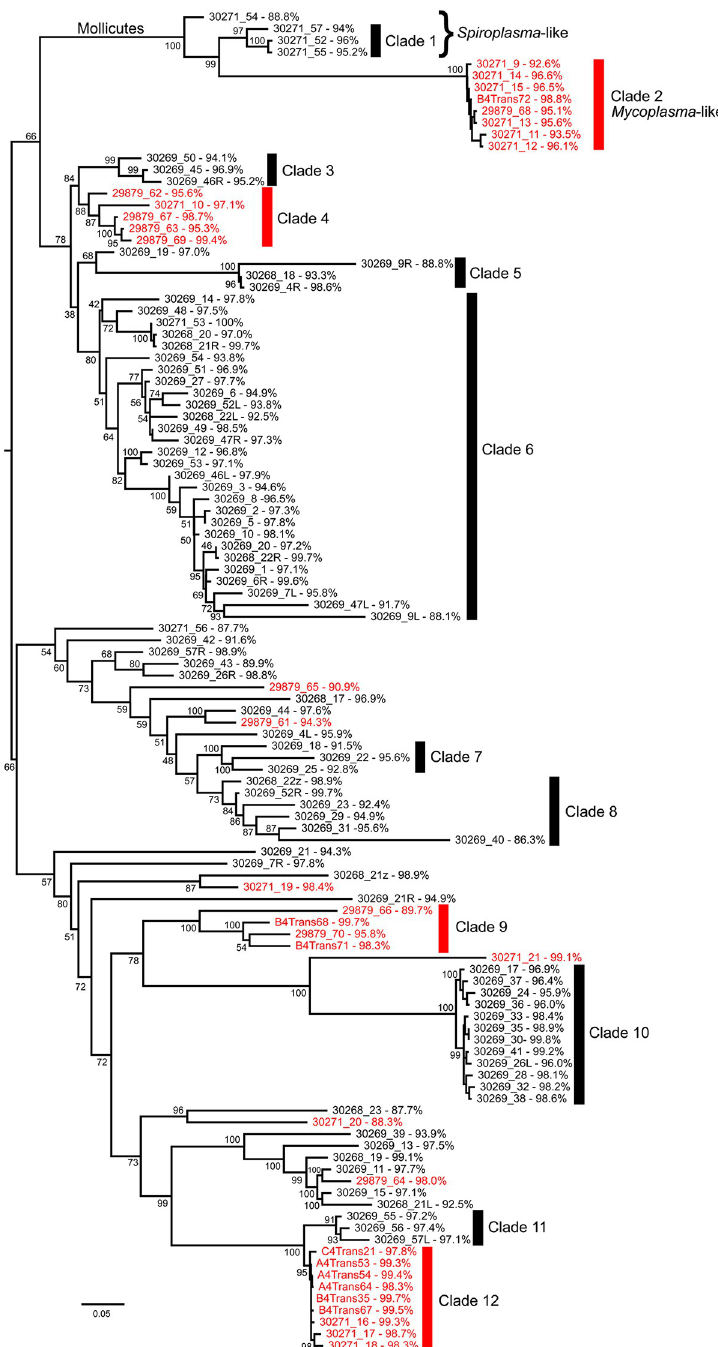
Fig 3. Phylogenetic tree showing species-specific clades for telson bacteria isolated from S . mesaensis and H . arizonensis . A Maximum Likelihood phylogeny was constructed based on the DNA sequences of 114 16S rRNA samples isolated from S . mesaensis (n = 32) and H . arizonensis (n = 82) telsons. Scorpion-specific clades are identified by vertical bars numbered 1–12 with samples from H . arizonensis indicated in black; S . mesaensis indicated in red. We considered clades to be scorpion-specific if they contained 3 or more taxa from a single scorpion species and were supported by bootstrap values greater than